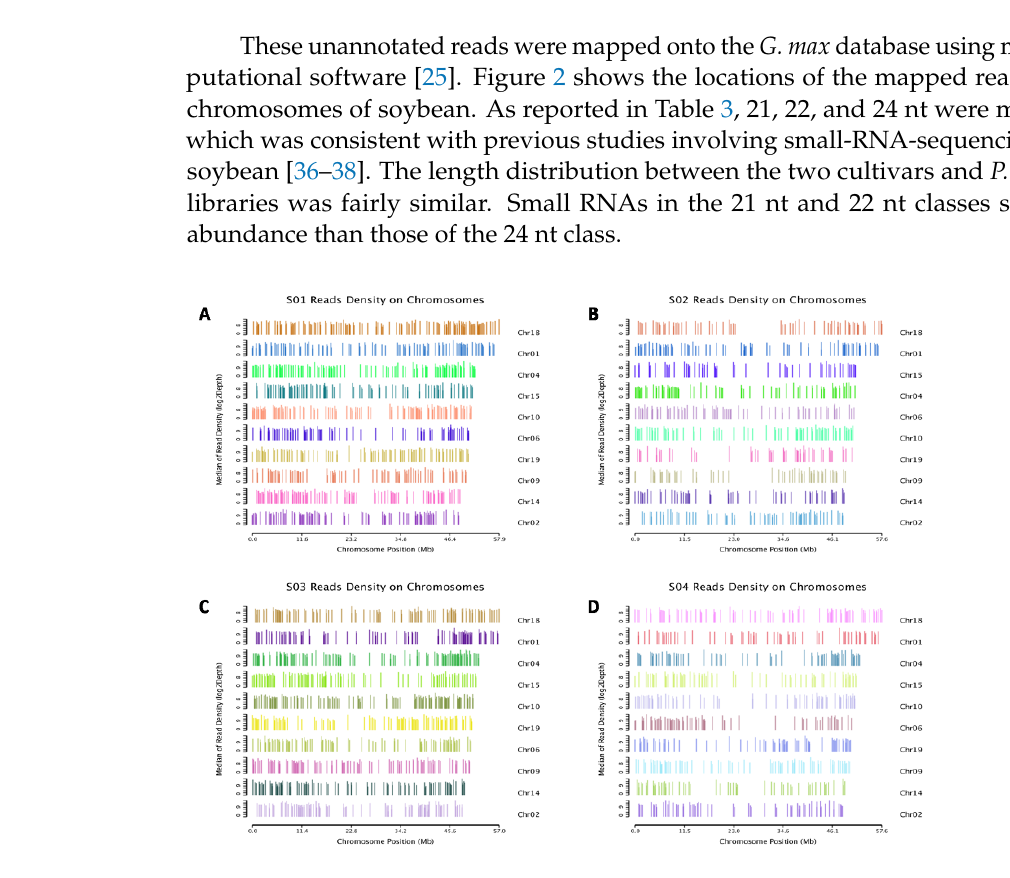
Table 2. sRNA classification annotation statistics.